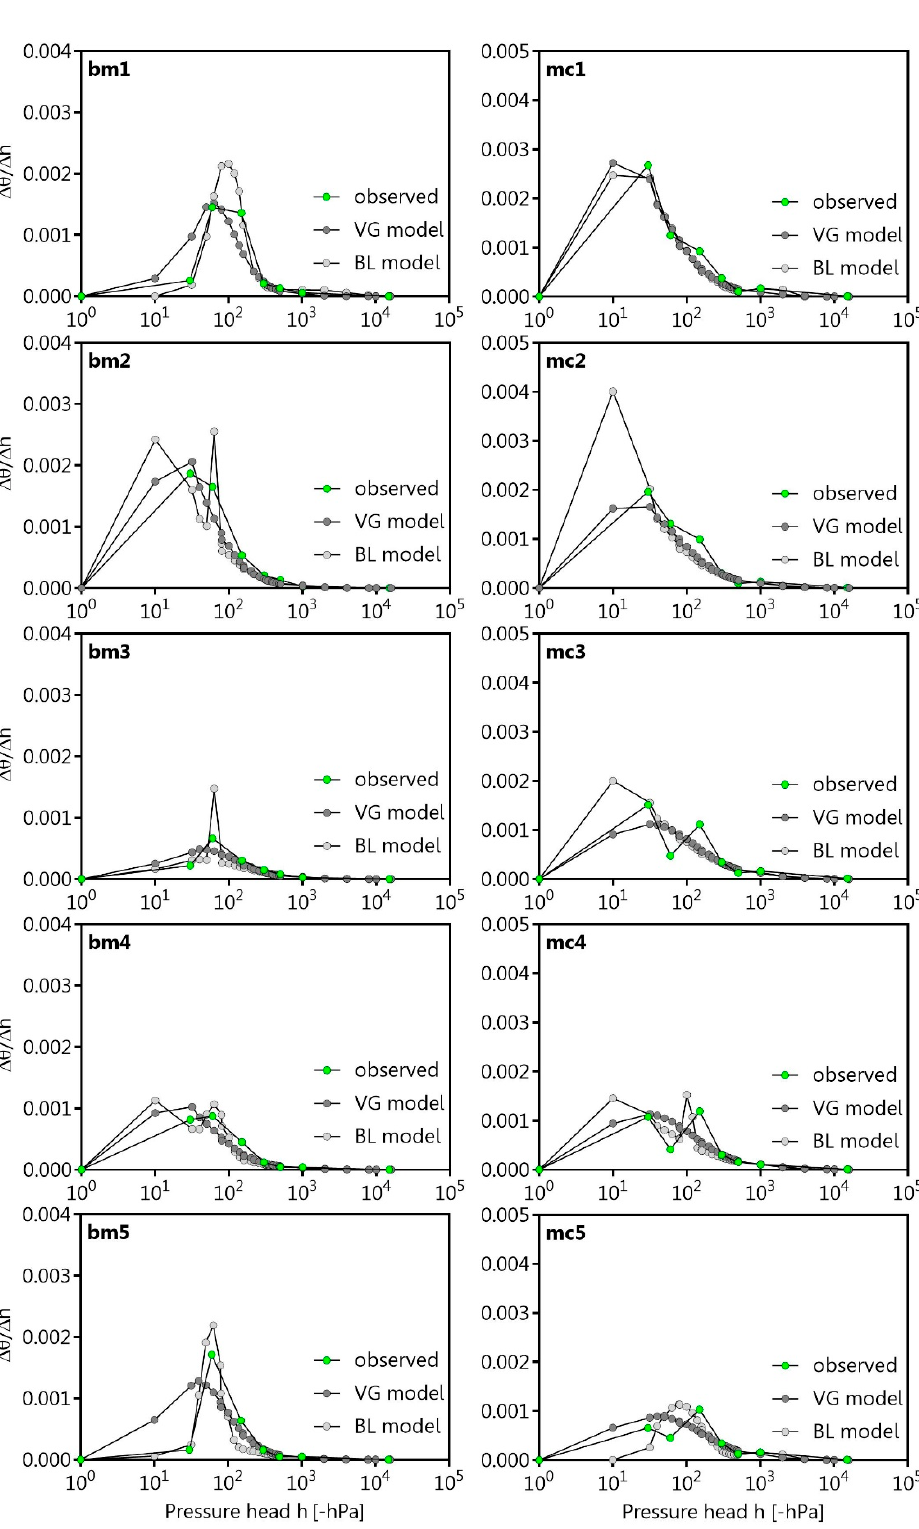
Figure 2. Fitted and observed pore size distribution as ratio of changing volumetric water content ( θ ) and pressure head (h) of the boulder marl (bm) and the marsh clay (mc) of five different Proctor stages (1–5) considering the VG model [9] and BL model [22].